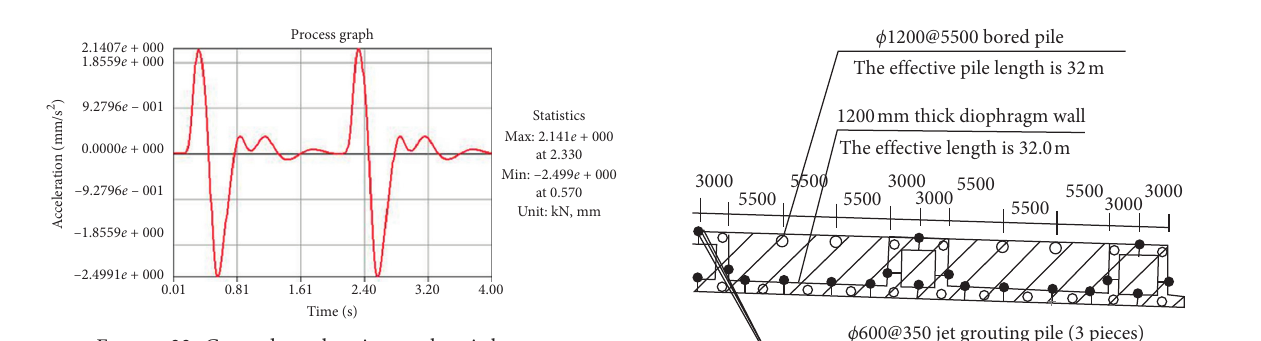
Figure 22: Ground acceleration at the pit bottom.